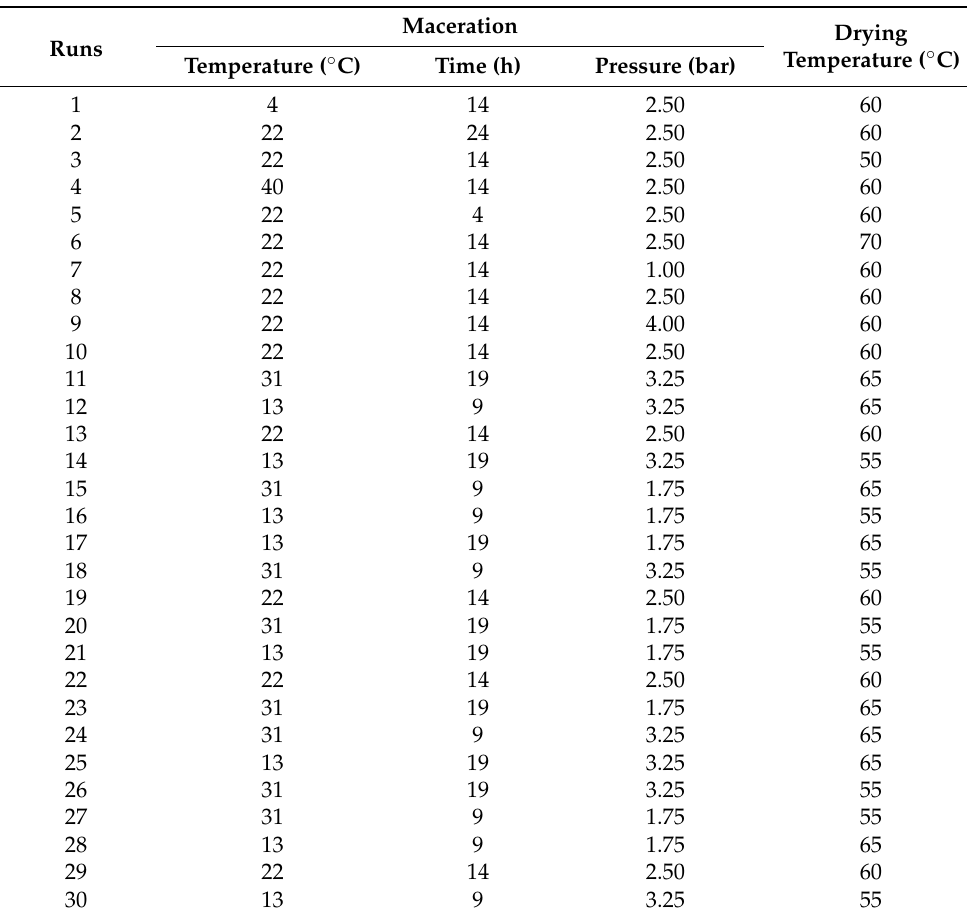
Table 2. Response surface methodology design of